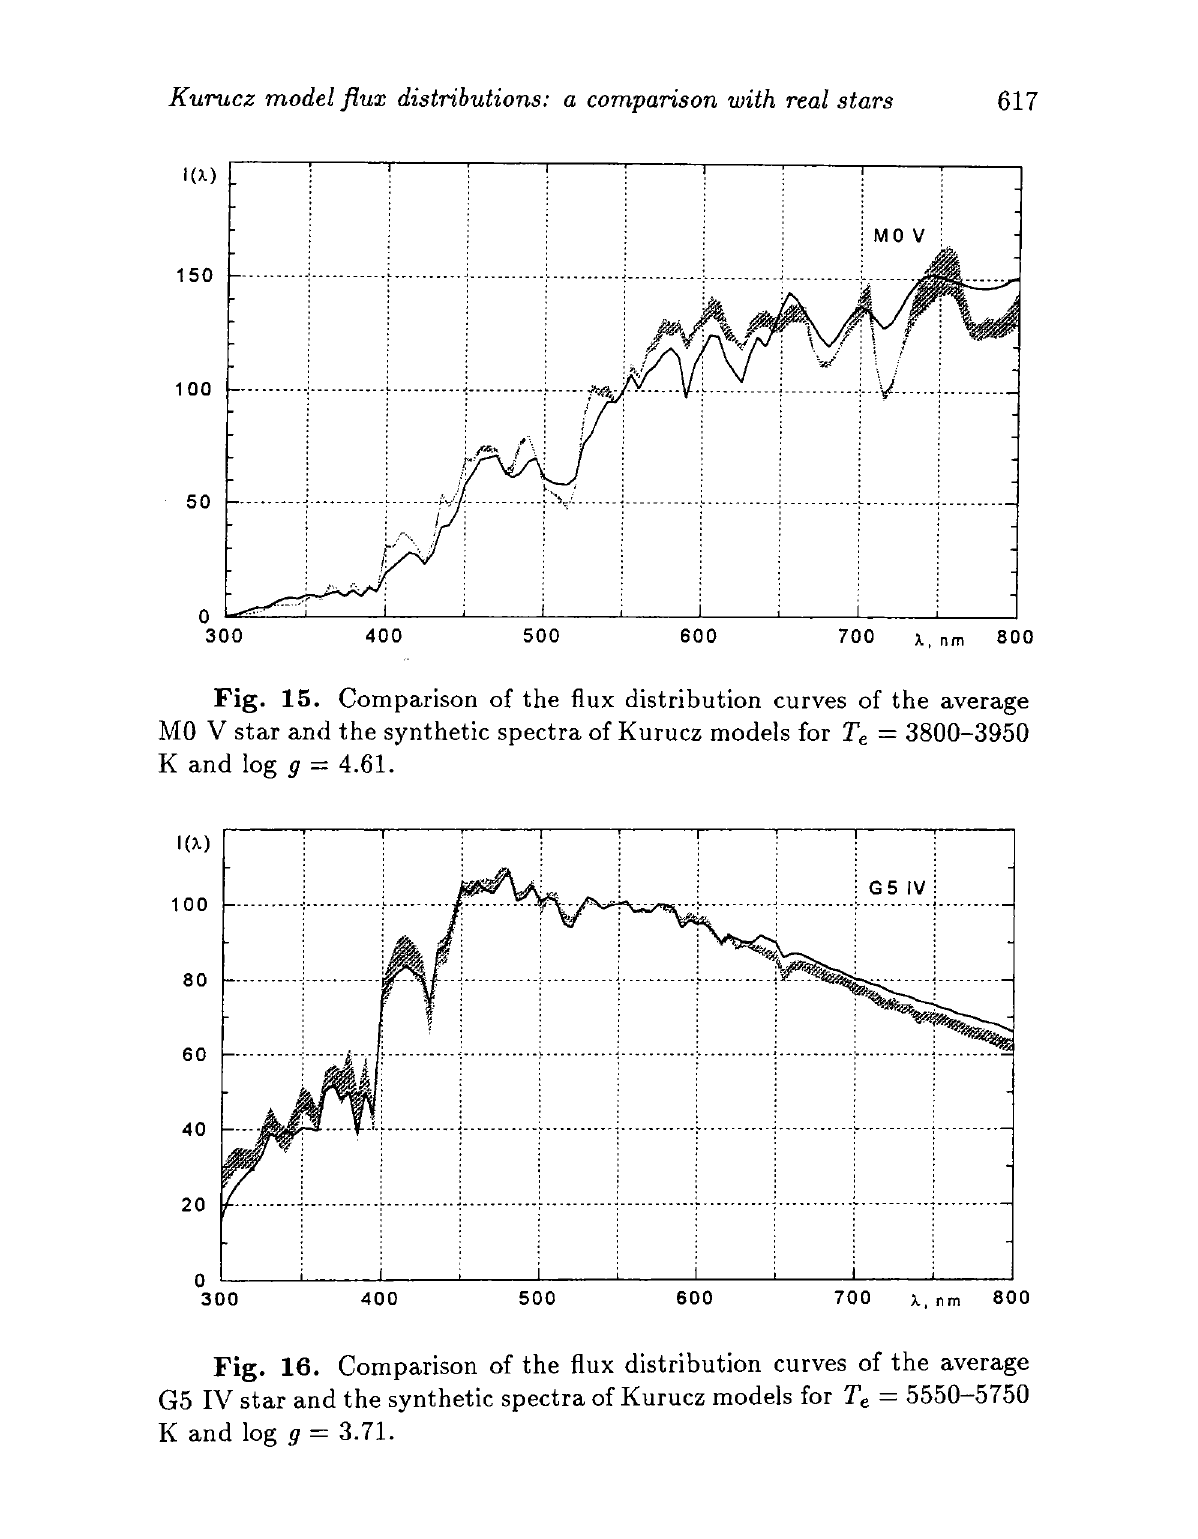
Fig. 16. Comparison of the flux distribution curves of the average G5 IV star and the synthetic spectra of Kurucz models for T e = 5550-5750 K and log g =